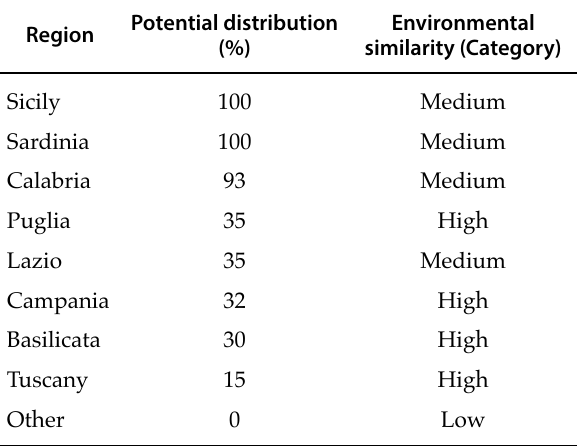
Table 3. Potential distribution of Xylella fastidiosa in the Italian regions (percent regional surface area potentially suitable for the bacterium) and environmental similarity between training and projection regions, according to the Maxent model and MESS analysis,